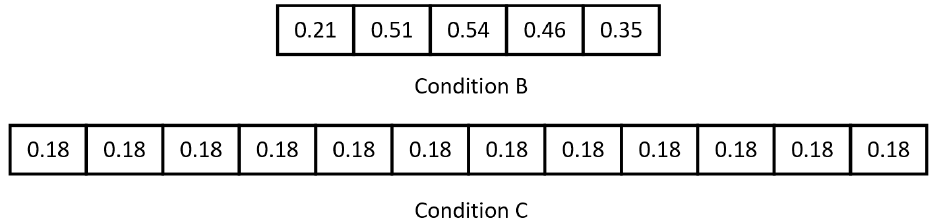
Figure 15. The optimal chromosome.